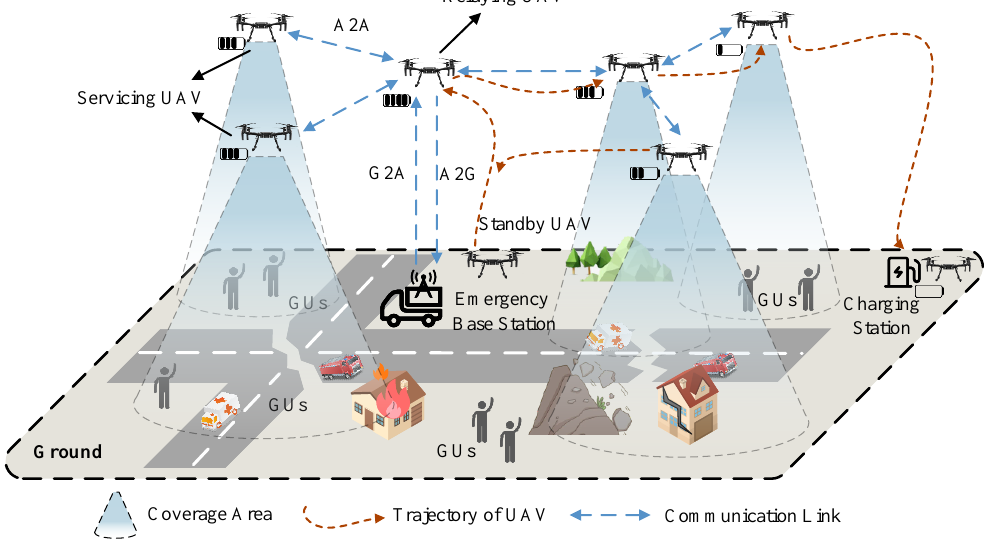
Figure 1. Multi-UAVs emergency communication